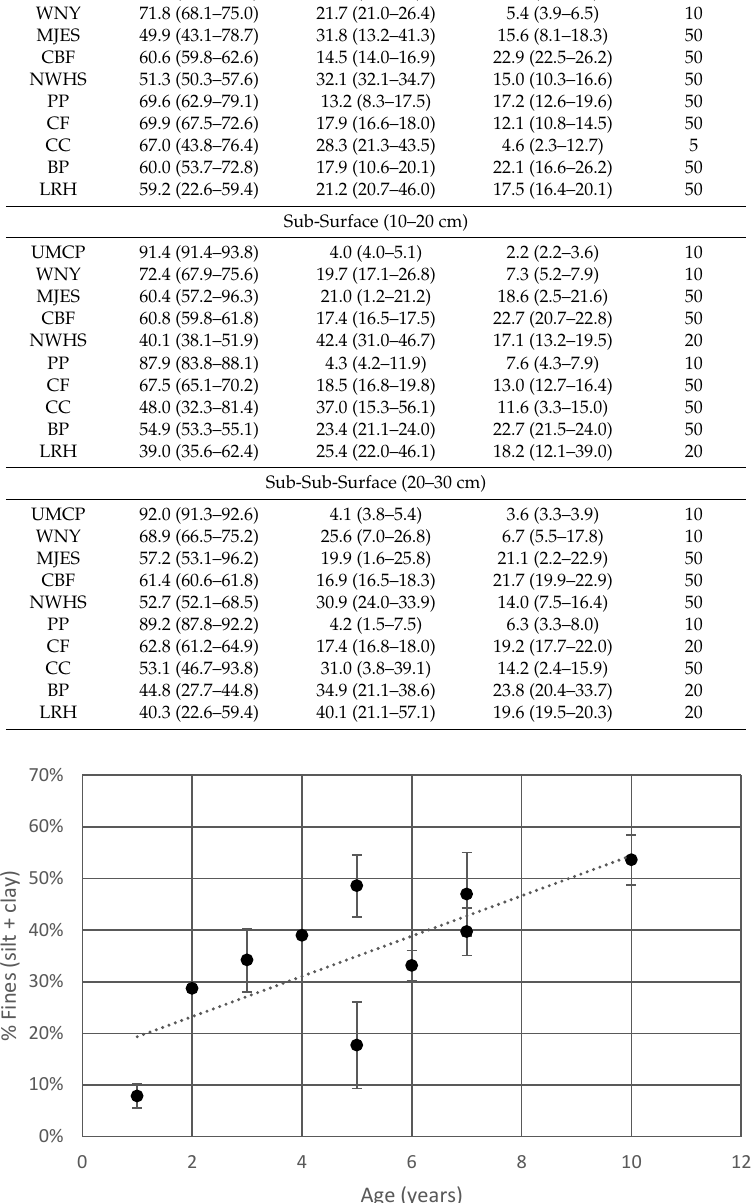
Figure 2. Fines content of bioretention media vs. time. Fines are defined as the sum of the silt and clay fractions. The value for each field site represents the mean value for all samples at all depths. Error bars represent the standard deviation from the mean.